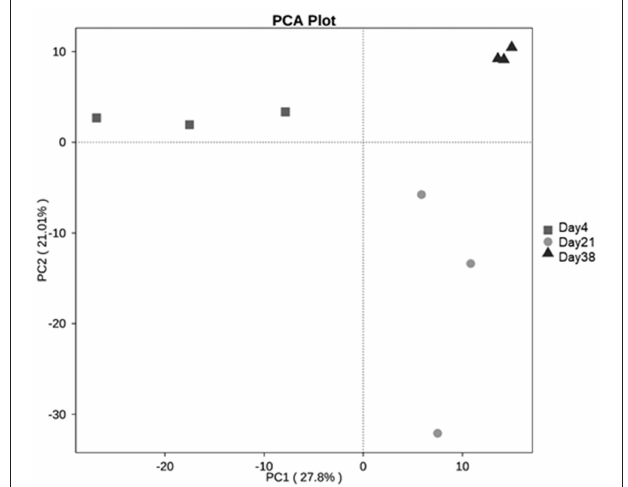
FIGURE 4 | PCA analysis based on the OTU levels of each sample. PC1 represents one principal component, PC2 represents another principal component, and the percentages represent the contribution of the principal components to the sample